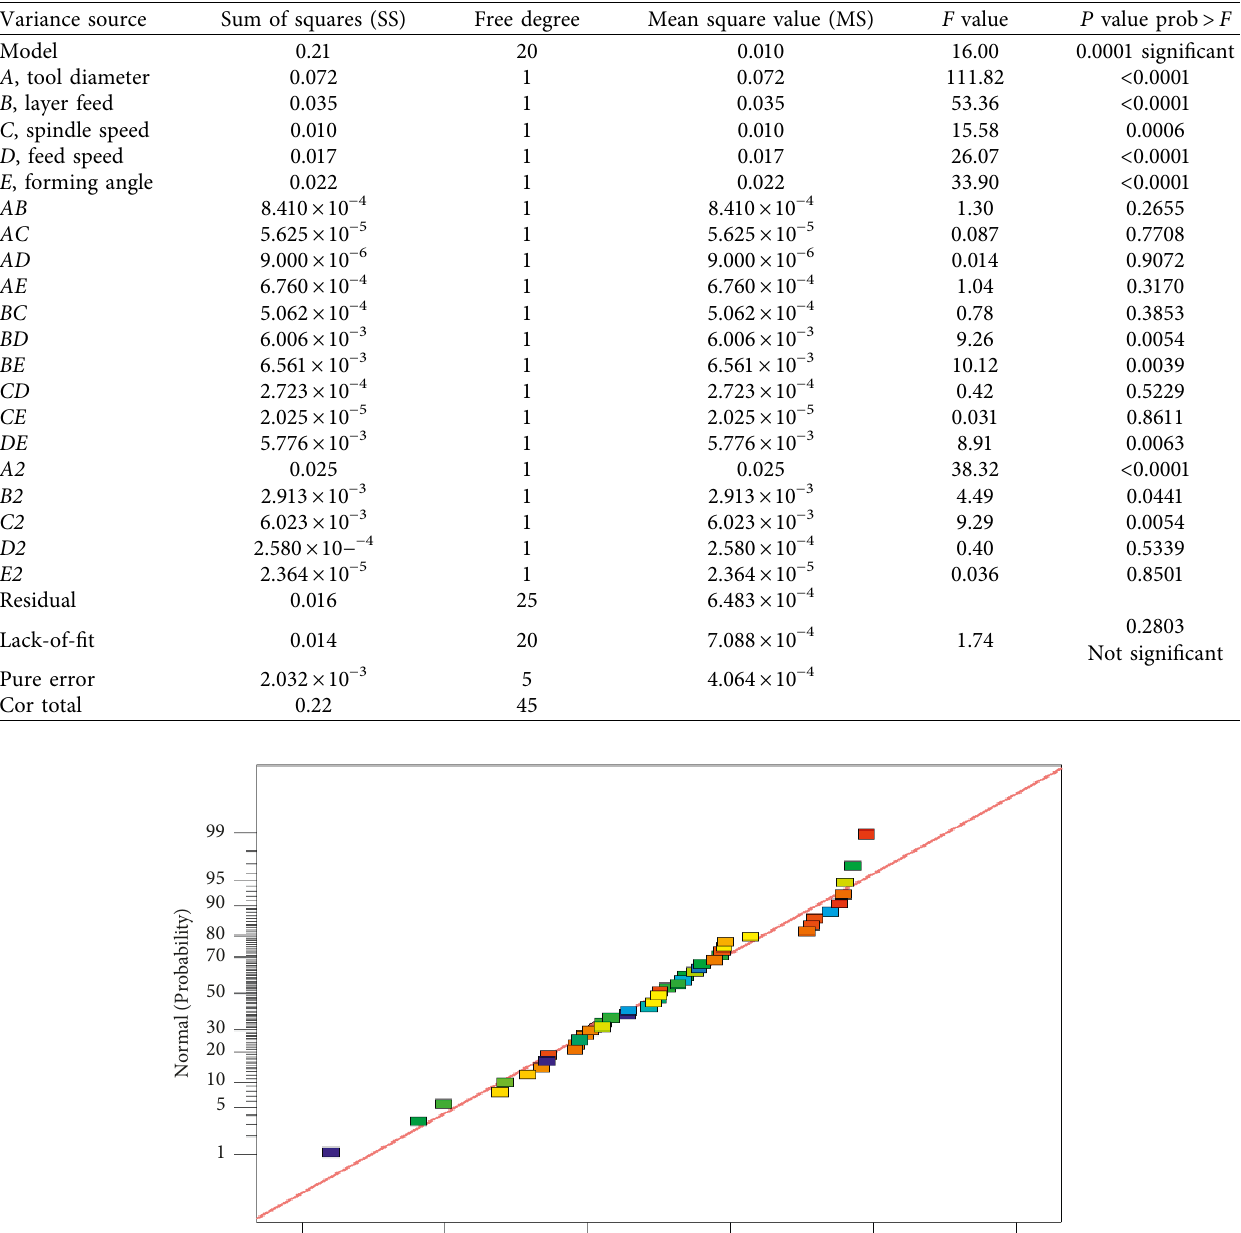
Table 5: Variance result of friction